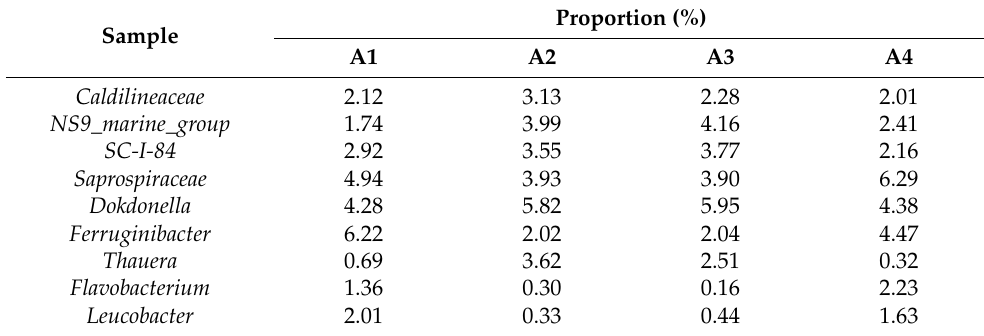
Table 3. Proportion of functional bacteria in different floating